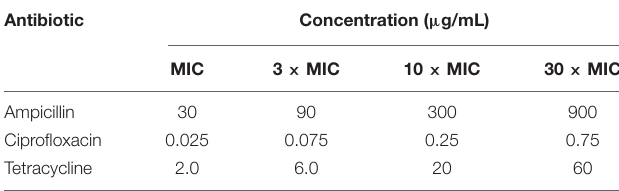
TABLE 2 | Antibiotics and concentrations used in the